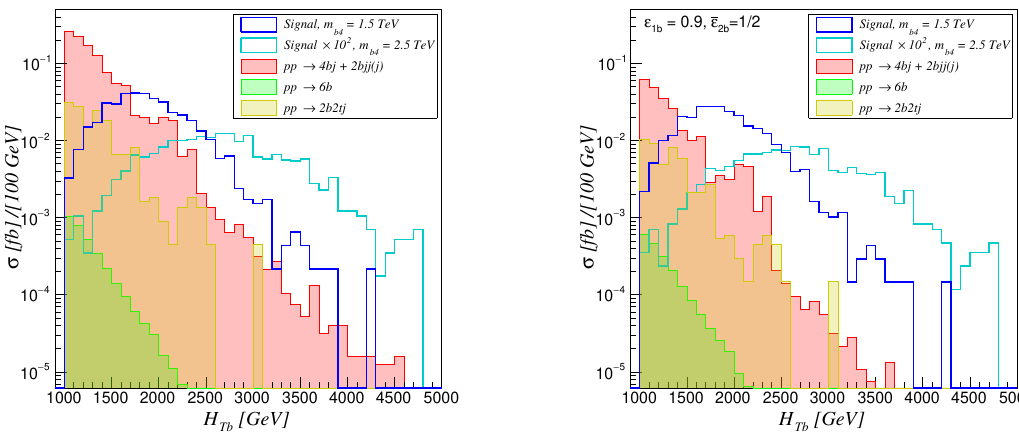
Figure 9 . Left: H Tb distribution of the 6 b signal and backgrounds in the 5b analysis. We show the signal distribution for m b = 1 : 5 and 2 : 5 TeV in blue and cyan respectively. We show the dominant 4 backgrounds, 4 bj + 2 bjj + 2 bjjj in the red shaded region. We show the subdominant backgrounds, 6 b and 2 b 2 tj , in the green and yellow shaded regions respectively. Right: H Tb distribution of the 6 b signal and backgrounds in the 5b analysis after incorporating the 1b/2b-tagging strategy